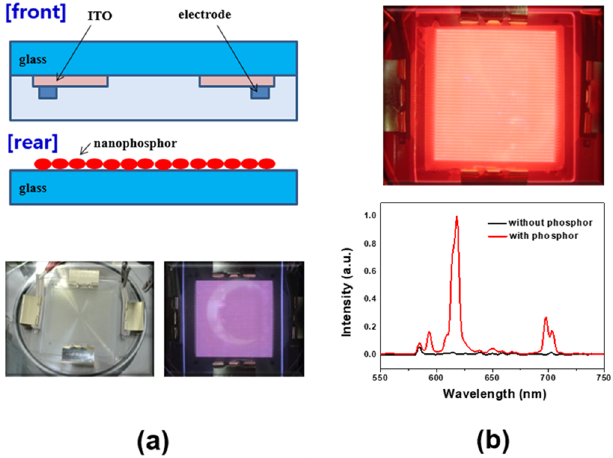
Figure 6. VUV panel test using the given YVO 4 :Eu 3+ nanophosphors. ( a ) Panel structure and